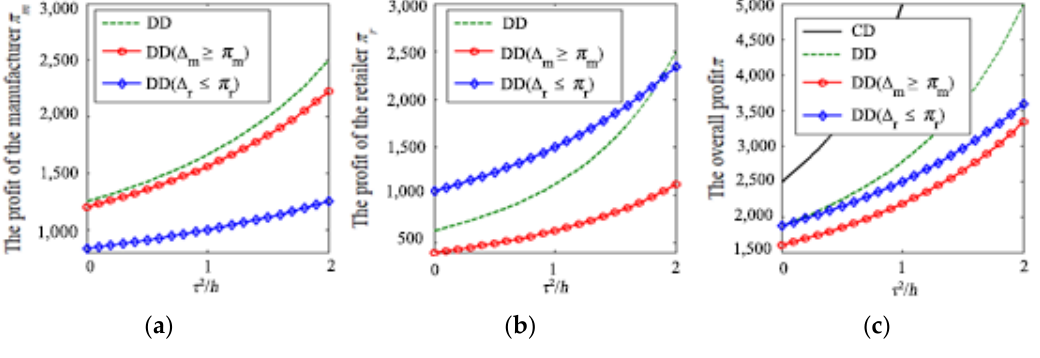
Figure 2. The effects of GECP on profits.